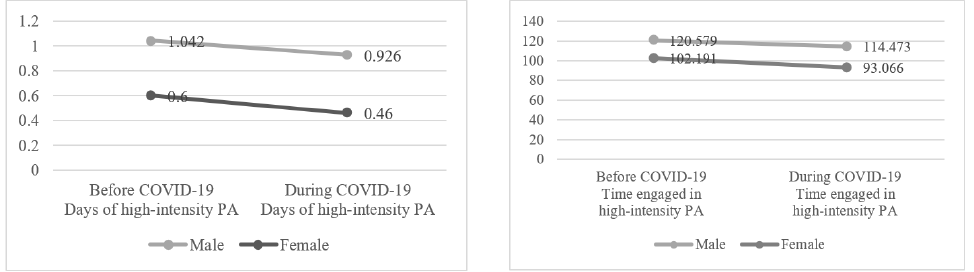
Figure 2. Changes in high-intensity PA by gender before and during COVID-19. Note: Time represents the number of minutes exercised per week.